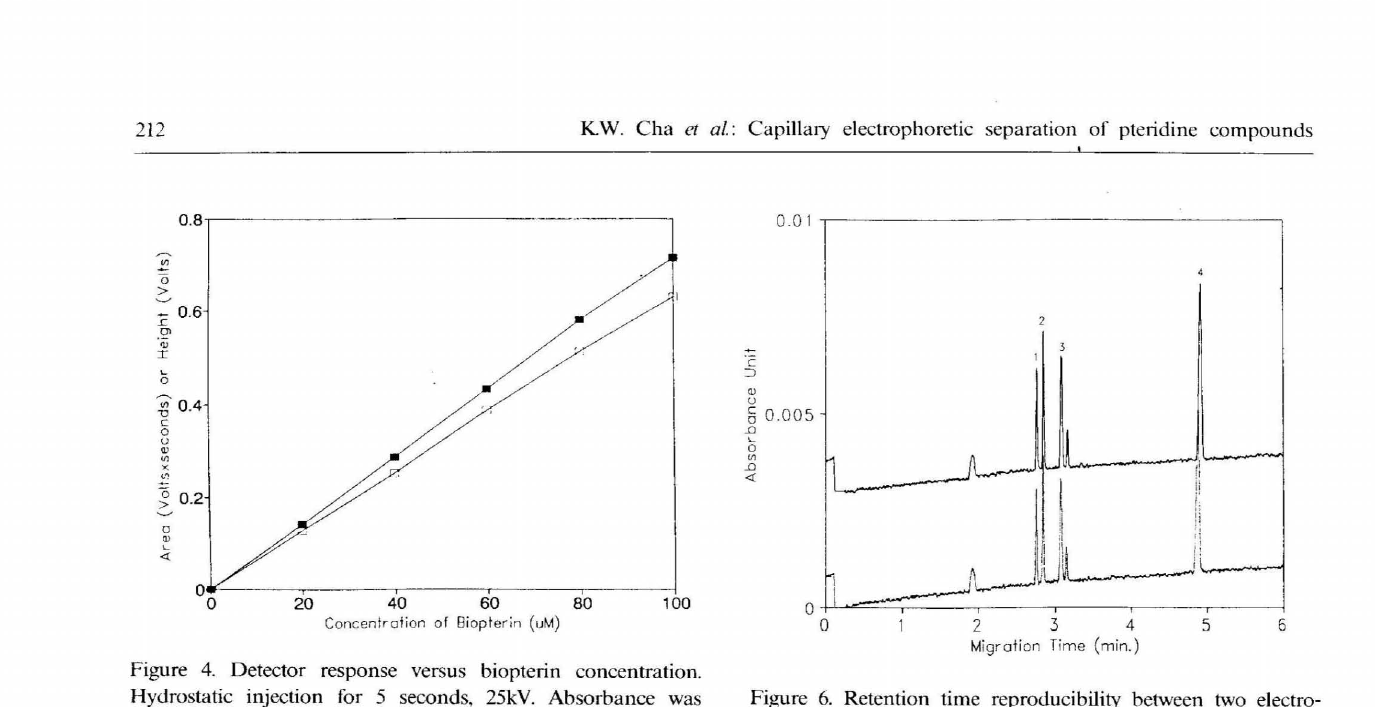
Figure 6. Retention time reproducibility between two electro pherograms of the same mixture with the interval of 6 runs. 1, biopterin; 2, neopterin; 3, monapterin; 4, 6-carboxypterin. The conditions are the same as Figure 4.